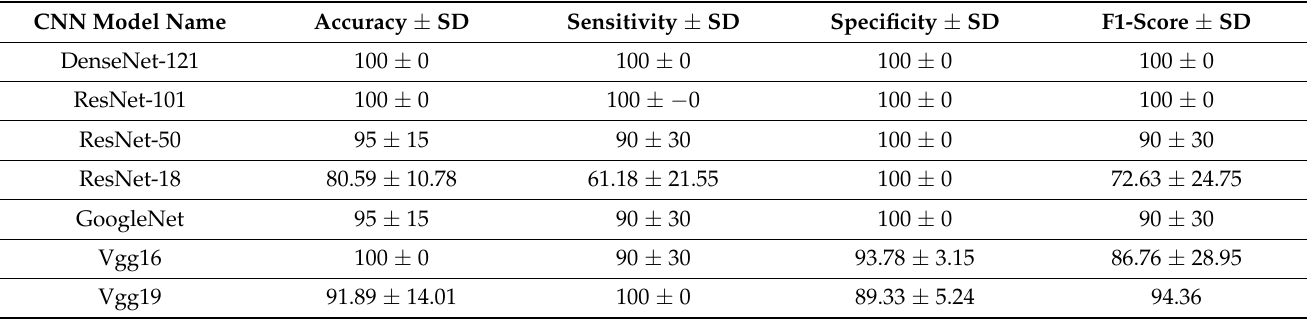
Table 4. Summary of the performance of the proposed method for K = 495 and different backbone CNN models on the DDSM